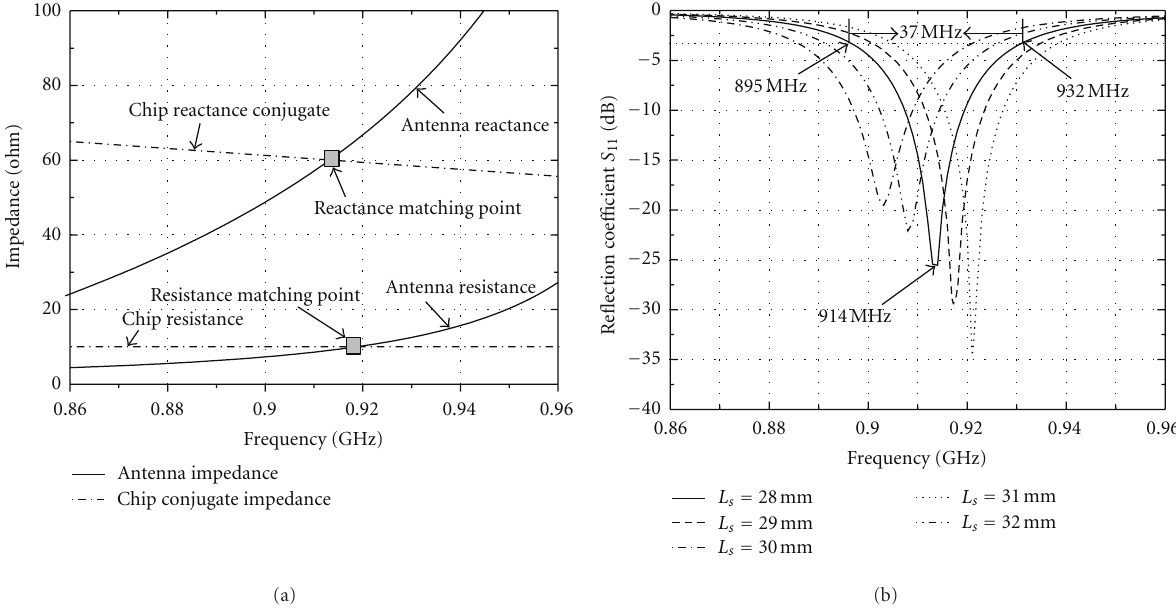
Figure 6: The input impedance and reflection coe ffi cient S 11 of the antenna with optimized parameters: (a) impedance, (b) reflection coe ffi cient S 11 .